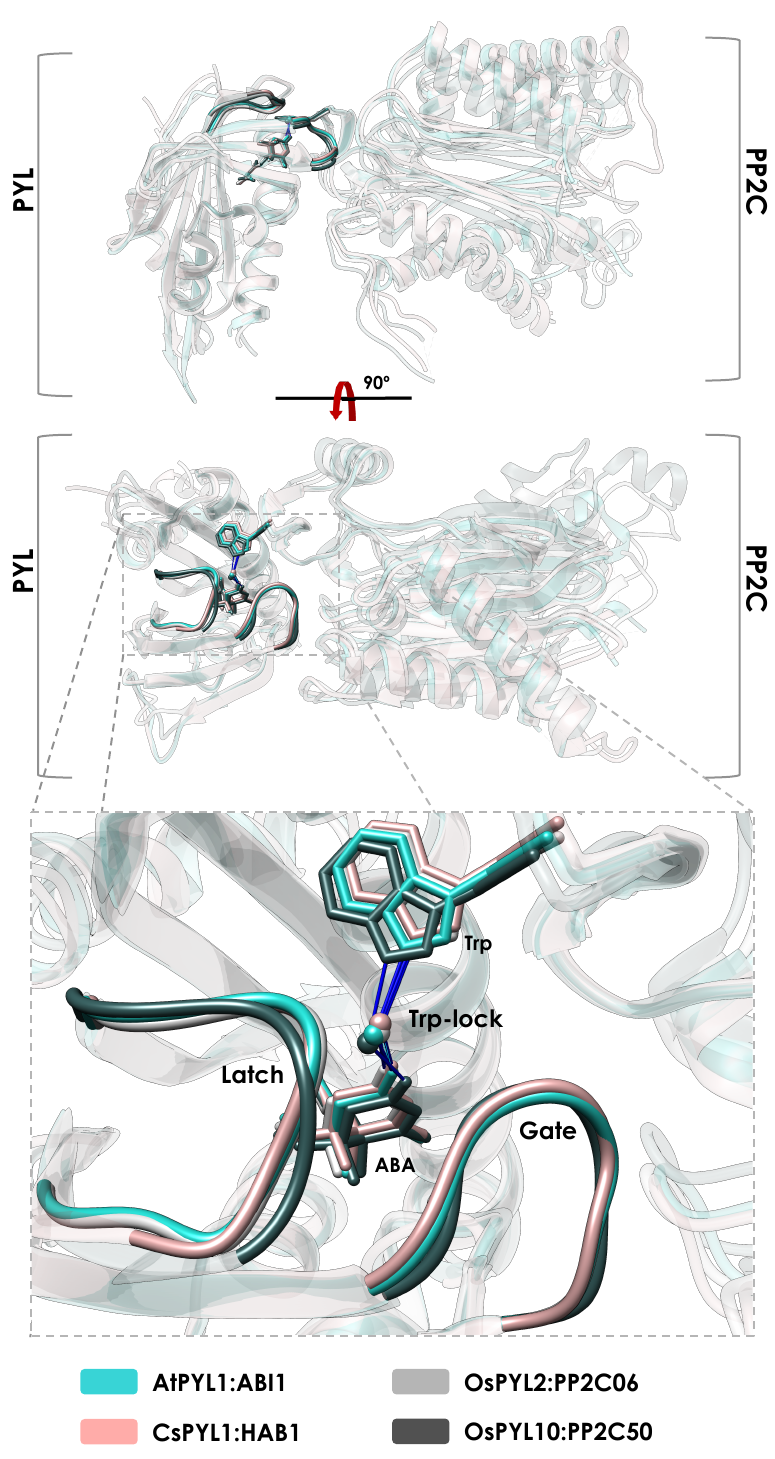
Figure 4. Arabidopsis and crop ABA-receptors adopt a similar latch-closed/gate-closed conformation upon PP2C binding. Structural alignment of PYL:ABA:PP2C ternary complexes from Arabidopsis thaliana (PDB ID: 3KDJ), Citrus sinensis (PDB ID: 5MN0) and Oryza sativa (PDB ID: 4OIC and 5GWP). The bottom panel shows a zoomed-in view of the PP2C tryptophan-lock highlighted in solid colors, similar to the gate and the latch